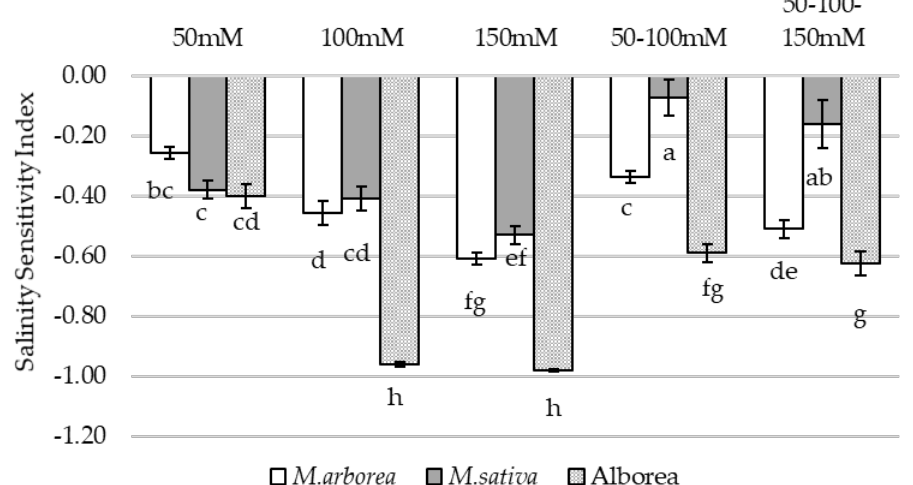
Figure 2. The salinity sensitivity index of M. arborea , M. sativa , and Alborea under control, 50 mM, 100 mM, 150 mM, 50–100 mM, and 50–100–150 mM NaCl. The vertical bars indicate the mean ± SE of five independent samples. The different letters refer to the significant differences at p < 0.05 (Tukey’s test).